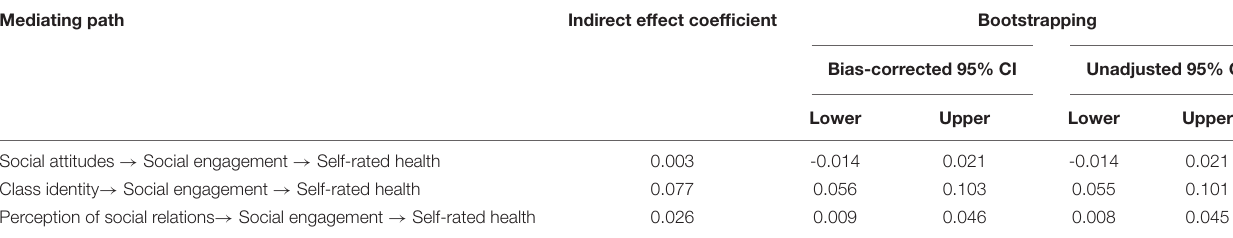
TABLE 6 | Mediating effect test